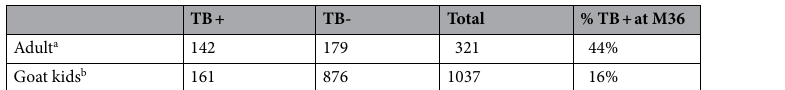
Table 3. TB prevalence at month 36 of trial by age of vaccination of goats from farms 1, 2, 3 and 5. a Adult goats vaccinated with BCG at M0. b Goat kids vaccinated at 2–3 months of age throughout the